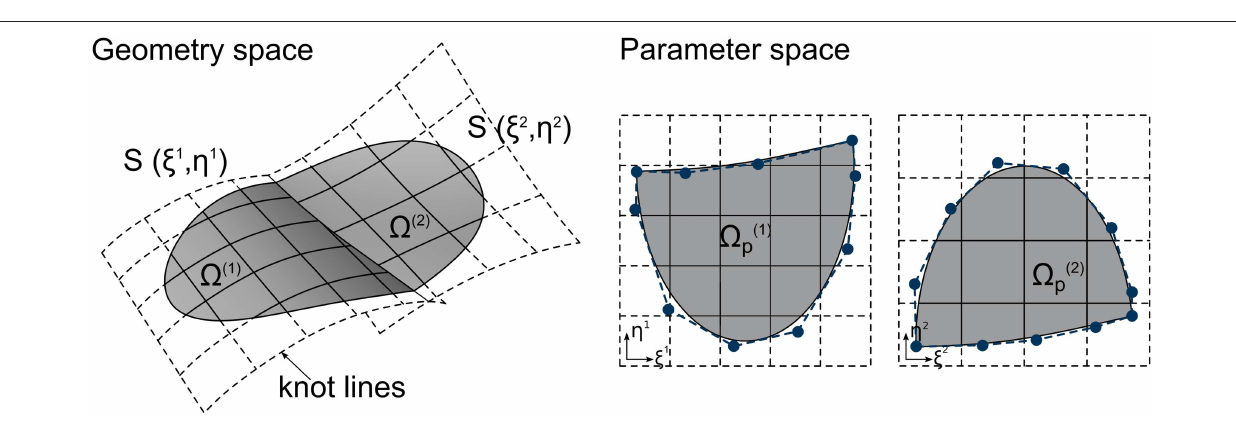
FIGURE 2 | Trimming curves in geometry space (left) and parameter space (right)